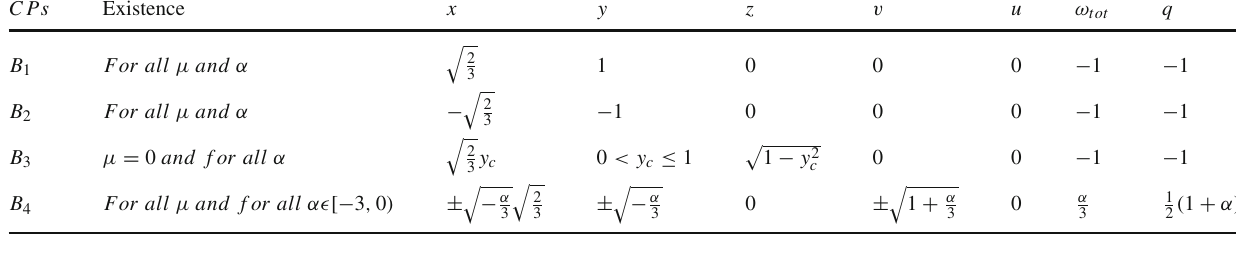
Table 7 The set of critical points, existence of critical points and the value of cosmological parameters corresponding to the critical points for the autonomous system (90–93) CPs Existence x